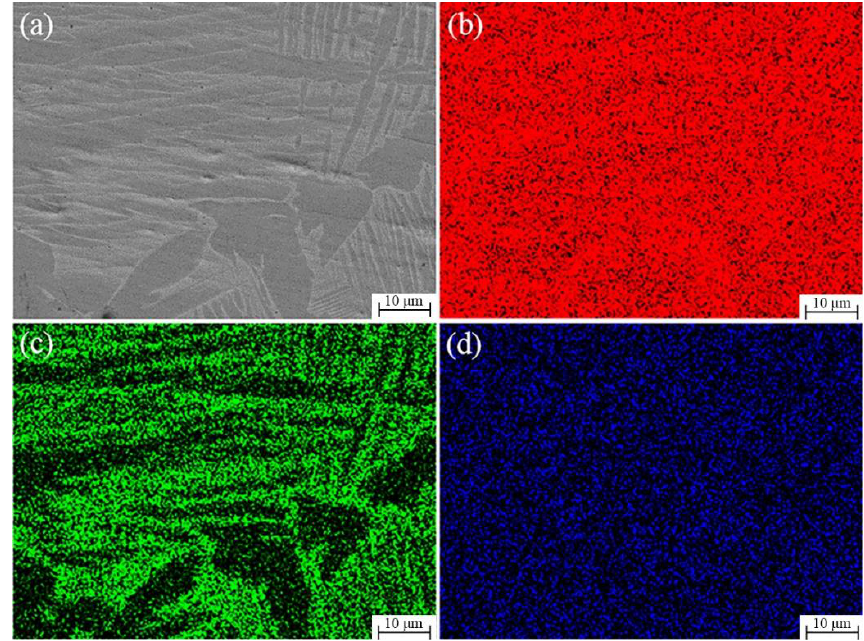
Figure 3. Elemental distribution in PM-fabricated Ti-10Nb-8Sn alloy: ( a ) SEM image, and elemental maps of ( b ) Ti, ( c ) Nb, and ( d ) Sn.